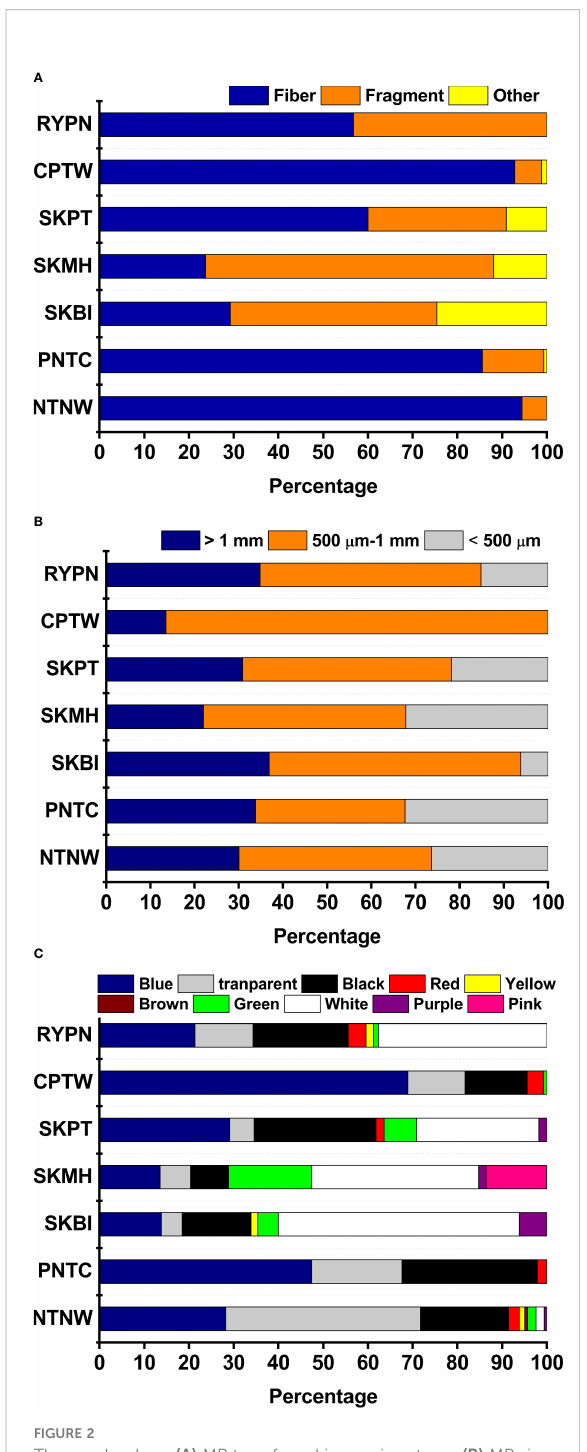
FIGURE 2 The graphs show (A) MP type found in pumice stone, (B) MP size found in pumice stone, and (C) MP color found in pumice